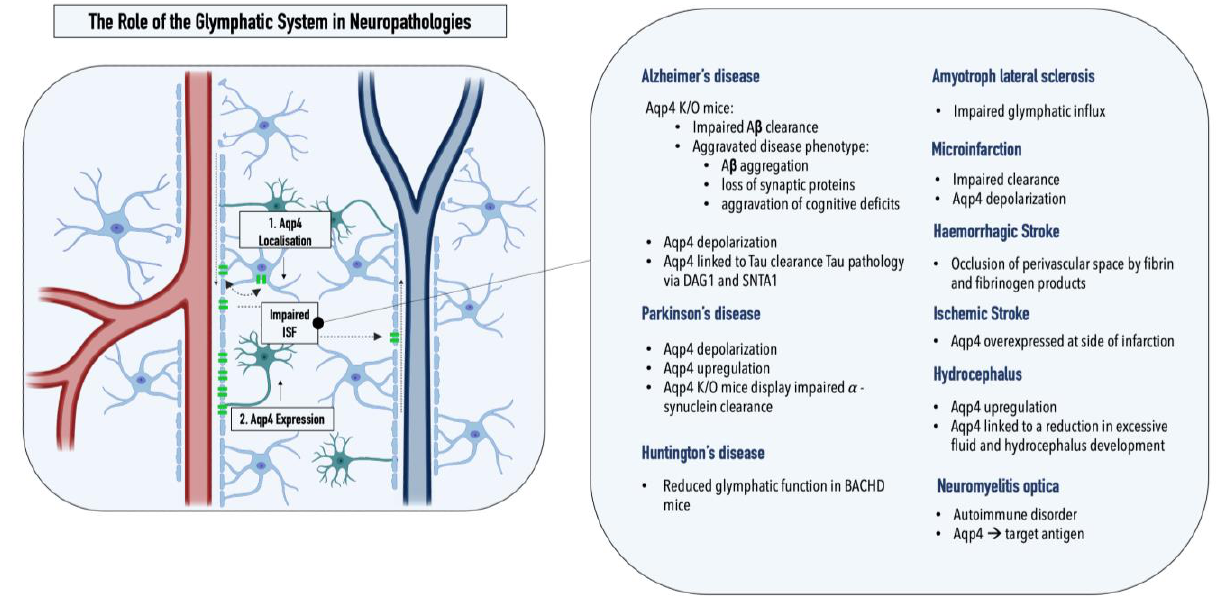
Figure 2. Graphical illustration of the two key pathological alterations in the glymphatic system observed in neuropathologies: ( 1 ) AQP4 depolarization and ( 2 ) altered AQP4 expression. Overview of pathological changes in the glymphatic system observed in various neuropathologies.